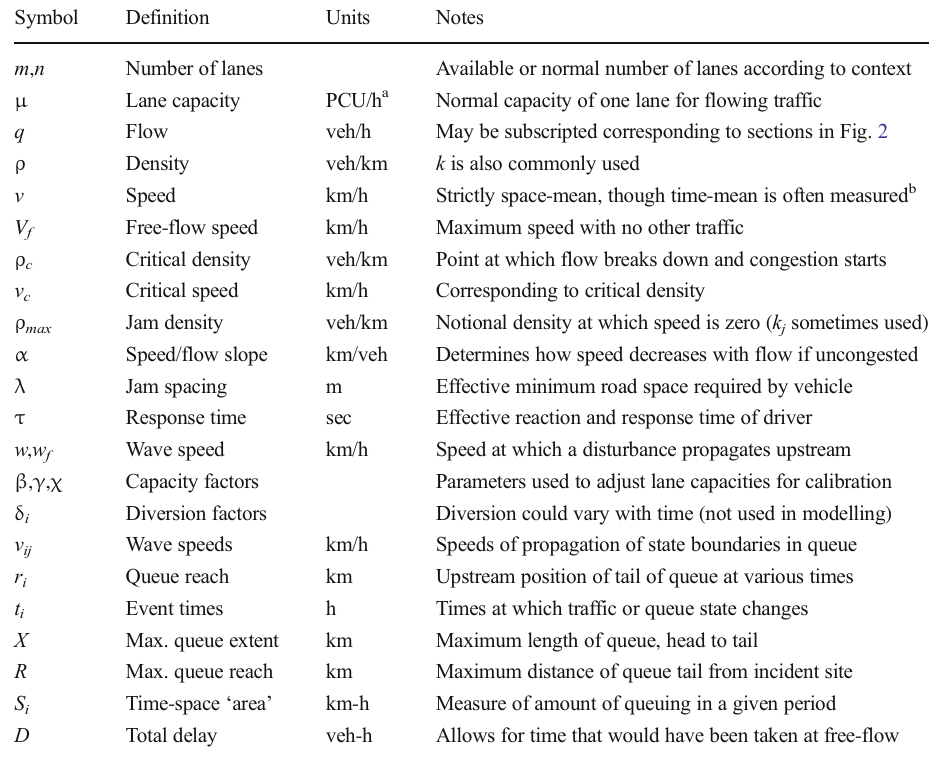
Table 2 List of variables used in this paper